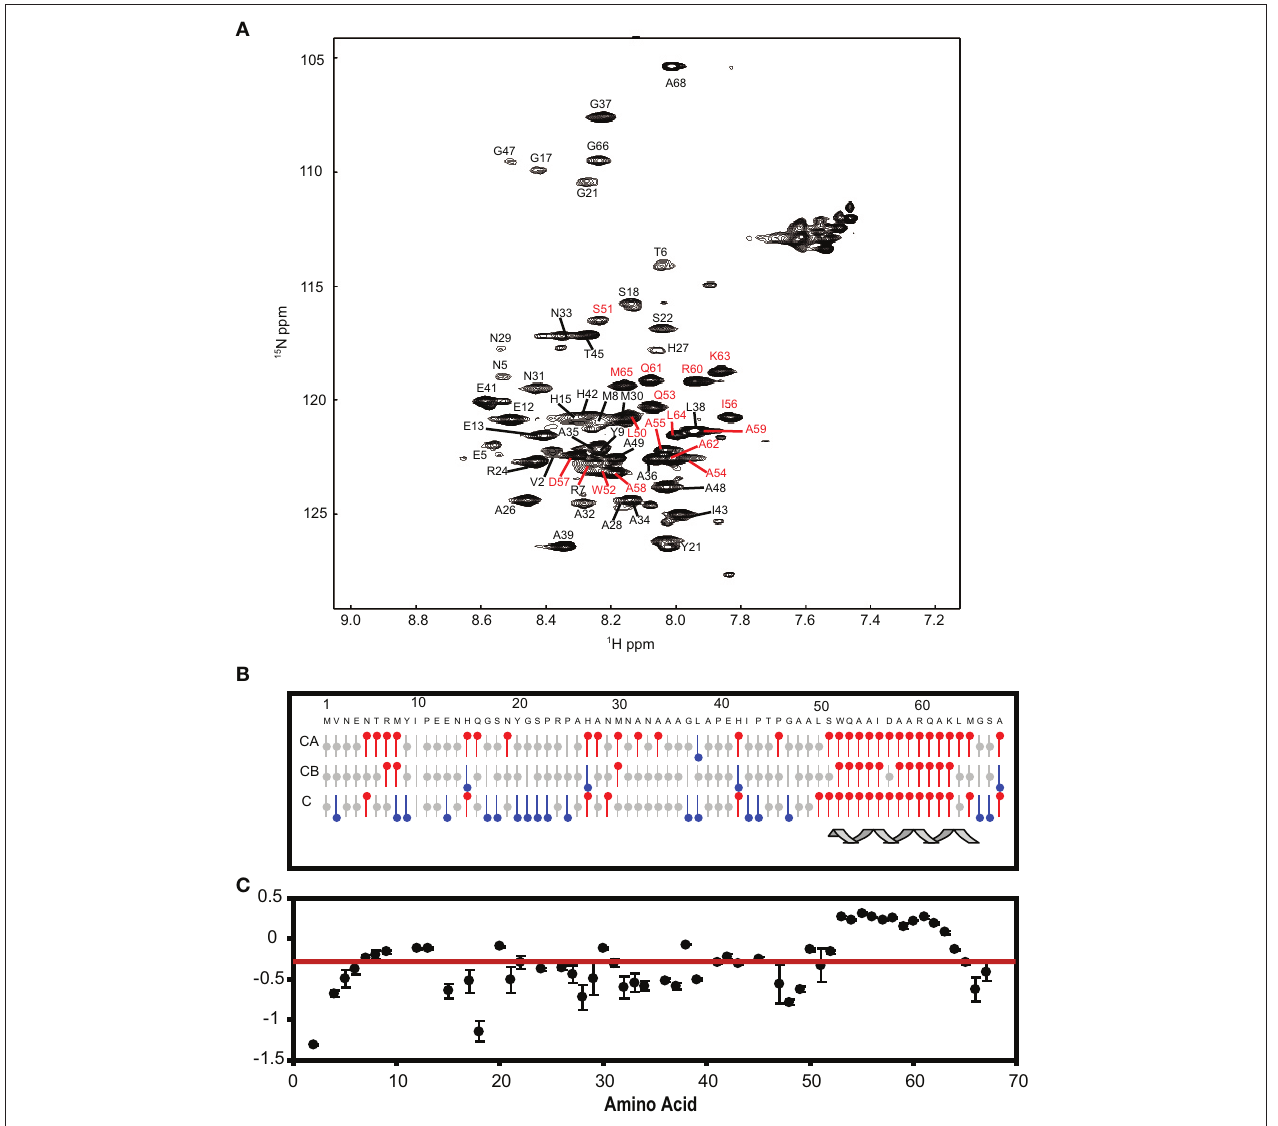
FIGURE 2 | (A) 1 H– 15 N HSQC spectrum of the long NSCaTE (AA 1–68) peptide. (B) Secondary structure prediction based on the 13 C chemical shifts of the long NSCaTE construct (Ca v 1.2NT 1 − 68 ). (C) Heteronuclear { 1 H}– 15 N NOE data for the long NSCaTE construct (Ca v 1.2NT 1 − 68